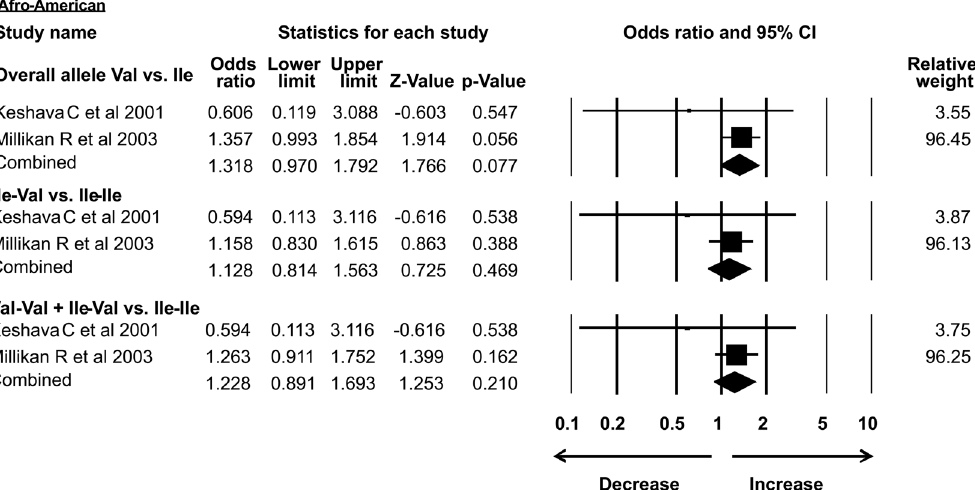
Figure 9. Forest plot: Her2 Ile 655 Val (rs1136201) gene polymorphism data from Afro-American sub group population showing OR and 95% CI for validating its association with breast cancer risk. Black square represents OR and horizontal line representing 95%